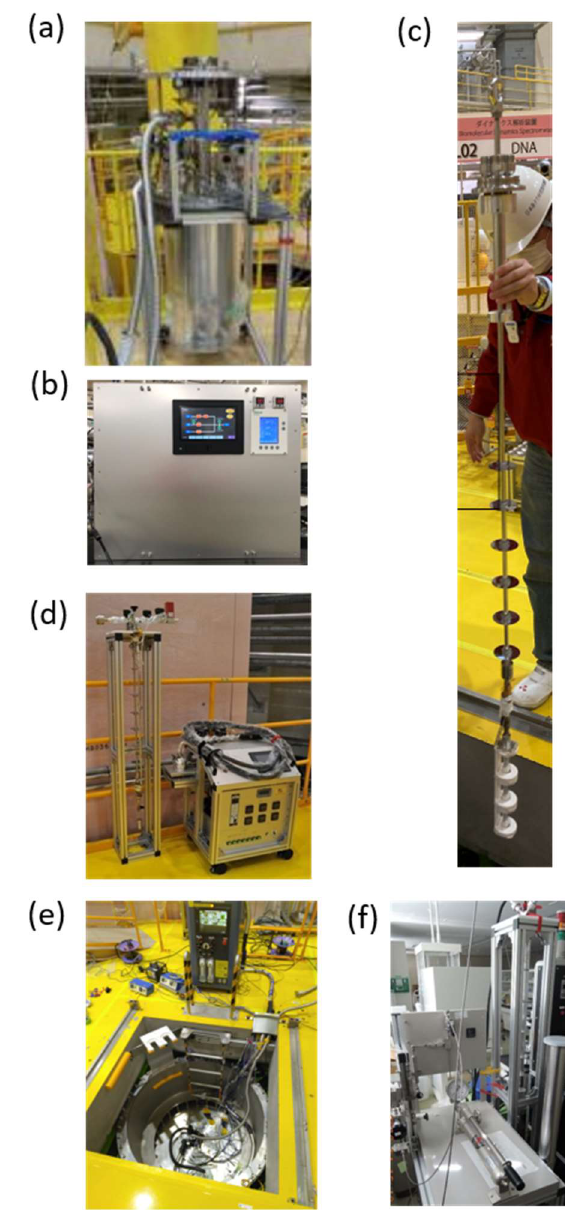
Fig. 7. (a) Standard cryo-furnace at DNA (5 K < T < 700 K), (b)gas handling system DICE, (c)sample stick with